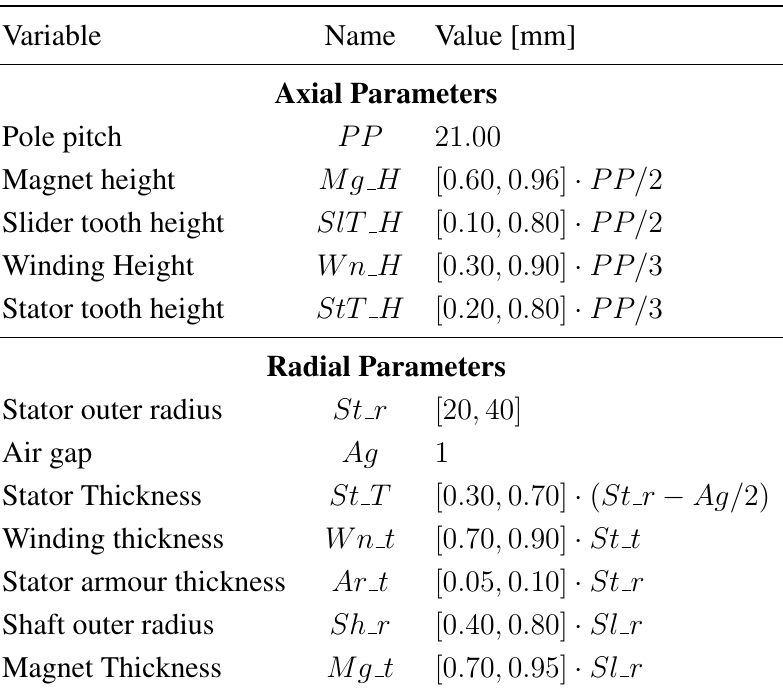
Table 1. Geometrical Parameters